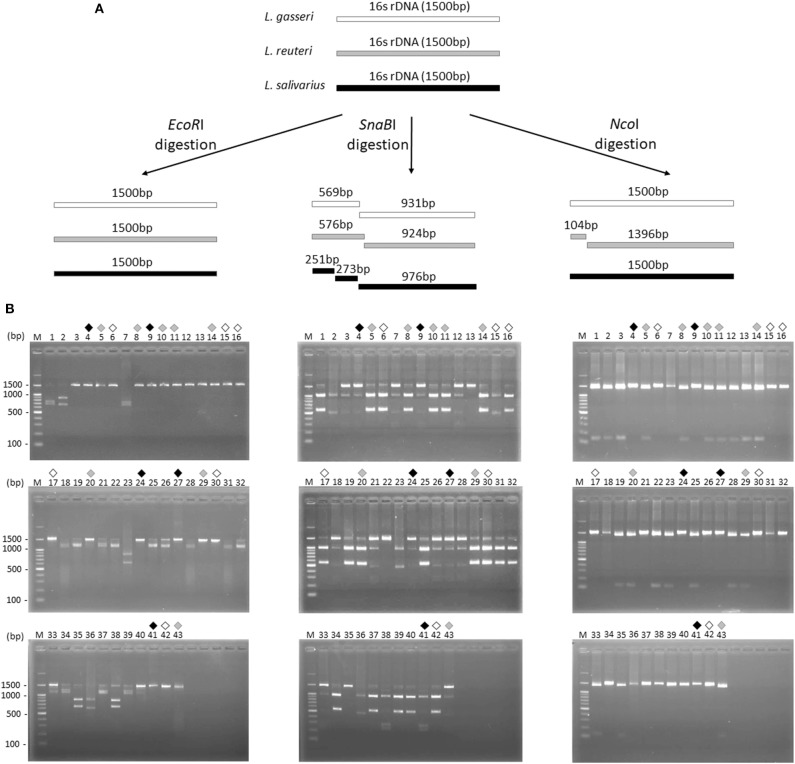
Restriction fragment length polymorphism analysis of 16S ribosomal DNA of three Lactobacillus species. (A) Illustration of the 16S rDNA fingerprint patterns of L. gasseri (white bar), L. reuteri (gray bar), and L. salivarius (dark gray bar) after EcoRI, SnaBI, and NcoI digestion, respectively. (B) The 16S rDNA fingerprint patterns digested with EcoRI (left panel), SnaBI (middle panel), and NcoI (right panel) of 43 colonies isolated from MRS agar plates. Suspected colonies of L. gasseri (black open diamond), L. reuteri (gray diamond), and L. salivarius (black diamond) were indicated.